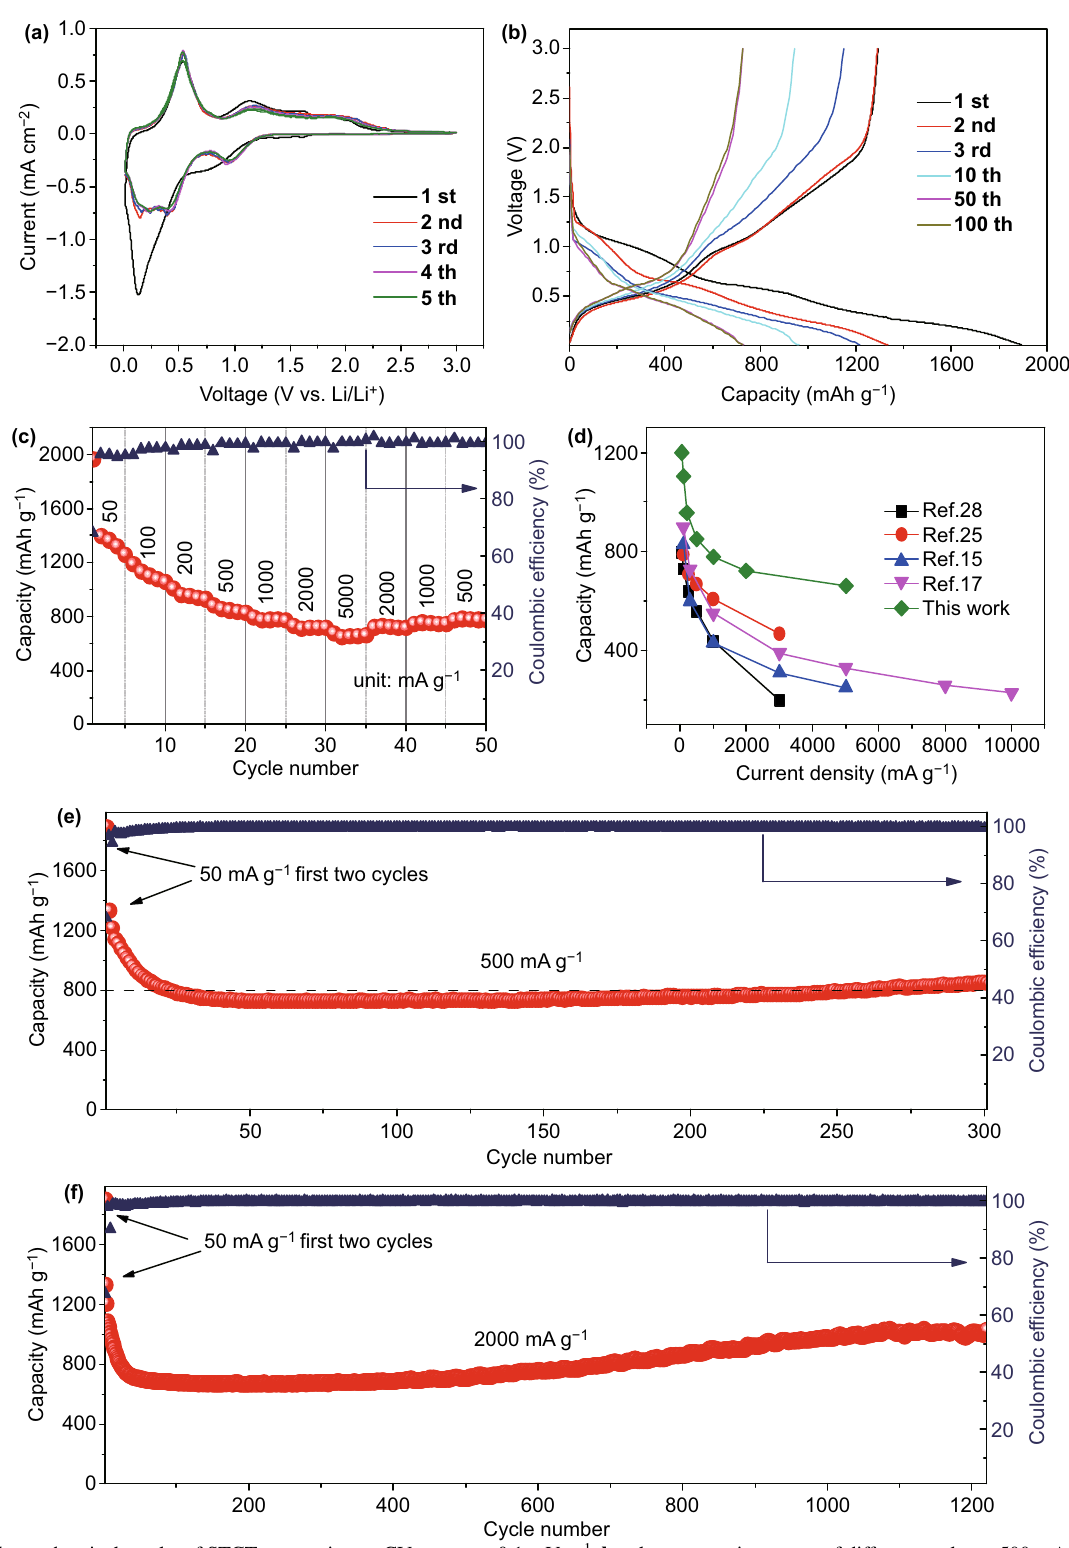
Fig. 5 Electrochemical results of STCT composites: a CV curves at 0.1 mV s −1 , b voltage–capacity curves of different cycles at 500 mA g −1 , and c rate performance. d Rate performance comparison of different pillared MXene‑based anode materials reported recently (just focus on closely related pillared MXene‑based composites), e cycle performance at 500 mA g −1 , and f long‑term performance at a high current density of 2000 mA g